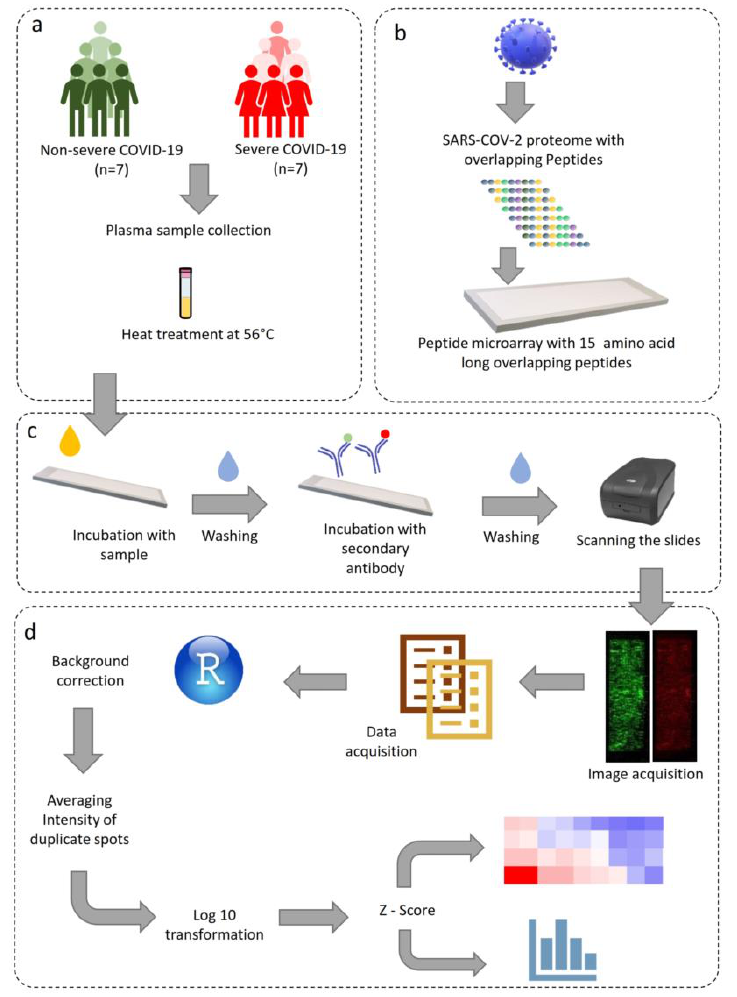
Figure 1. Schematic representation of the study design, microarray protocol, and data analysis. ( a ) Sample acquisition and heat inactivation of virus, ( b ) SARS-CoV-2 whole proteome microarray design, ( c ) microarray staining and image acquisition, ( d ) data analysis pipeline.